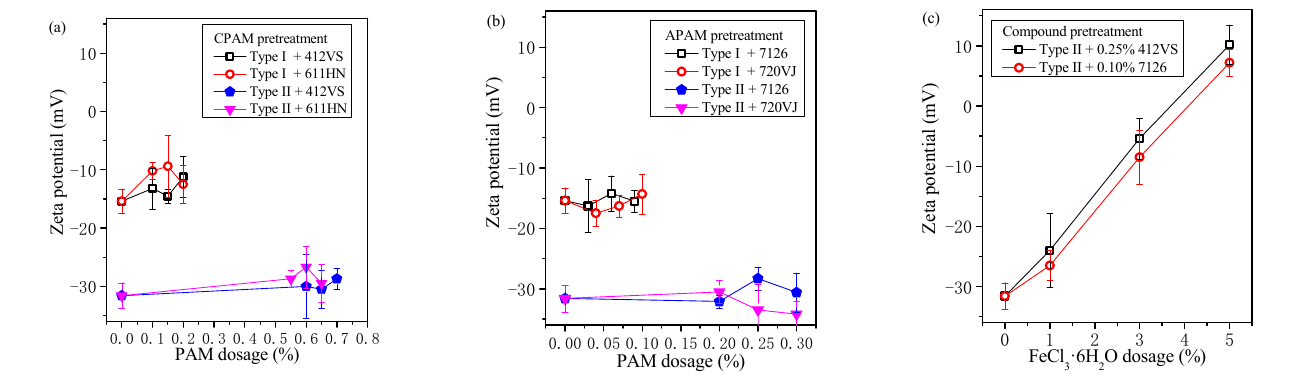
Figure 10. Zeta potential after pretreatment. ( a ) CPAM. ( b ) APAM. ( c ) FeCl 3 + PAM.